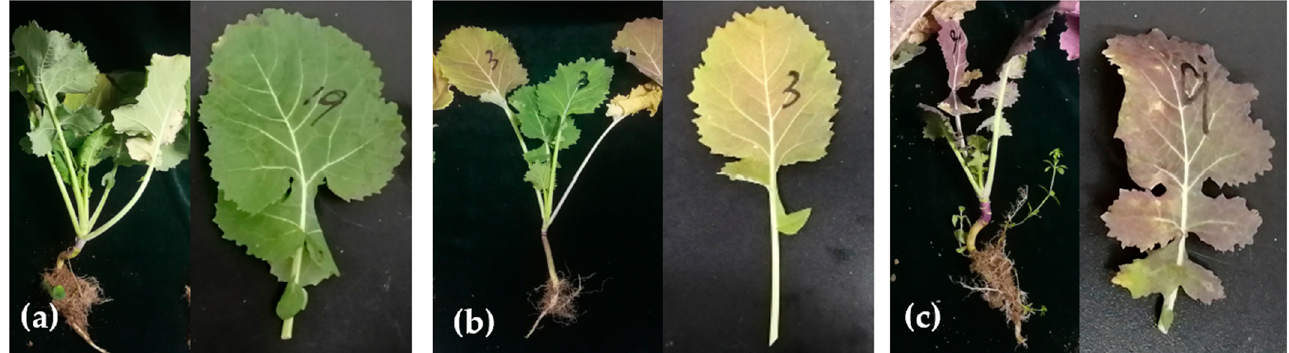
Figure 2. Typical BrYV symptoms occurring mainly in three types of plants in the field. ( a ) Type I, plant without significant symptoms but tested BrYV positive; ( b ) Type II, BrYV-infected plant with leaf yellowing; ( c ) Type III, BrYV-infected plant with conspicuous red or purple